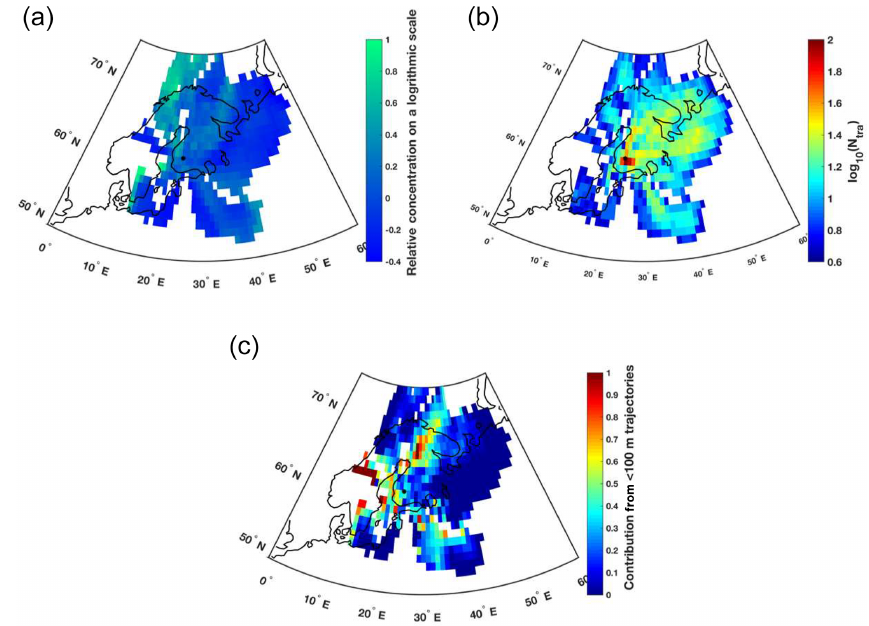
Figure 3. (a) Trajectory-based frequency plot of the [INP] across the entire campaign. The concentration fields are shown on a logarithmic scale, and the colour bar indicates the deviation from the measured median INP number concentration of 12.8L − 1 (zero on the colour bar). (b) Number of trajectories passing through each grid cell. (c) Fraction of trajectories shown in panel (b) that pass at an elevation of < 100ma.g.l. In all panels, the grid size is 1 ◦ × 1 ◦ , and only those grid cells with at least five trajectories passing through them are shown. The location of the Hyytiälä Forestry Field Station is marked using a black